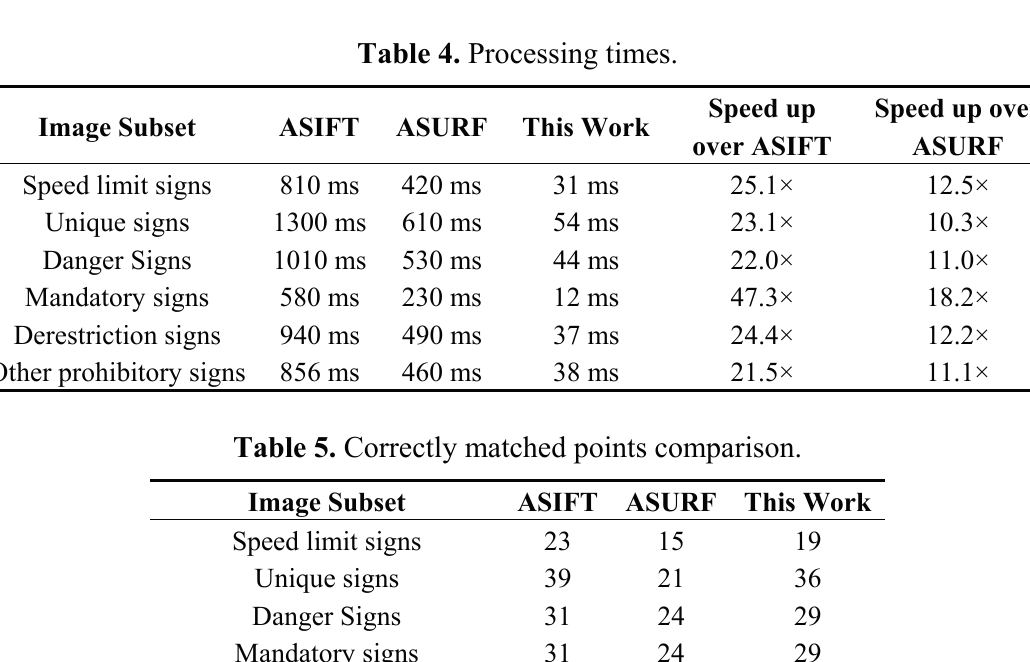
Figure 6. Parts of recognition results on GTSRB data set: ( a ) original image; ( b ) preprocessing to locate the candidate regions; ( c ) traffic sign recognition; ( e ) original image; ( f ) preprocessing to locate the candidate regions; ( g ) traffic sign recognition.